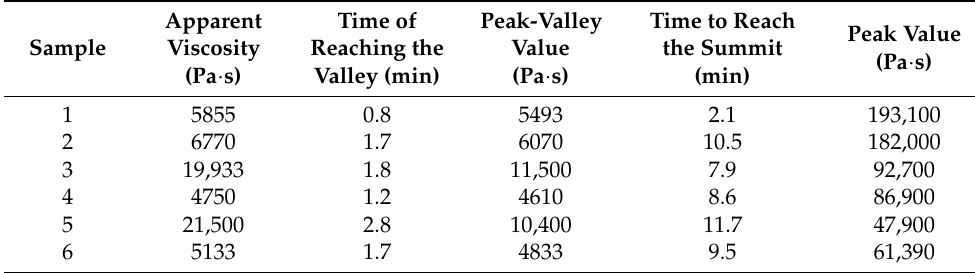
Figure 2. Viscosity curve of PA56T under nitrogen and air atmosphere at 280 °C. Table 2. The apparent viscosity of PA56T with antioxidants, the minimum and maximum of viscosity, and the time of each stage (starting from 10